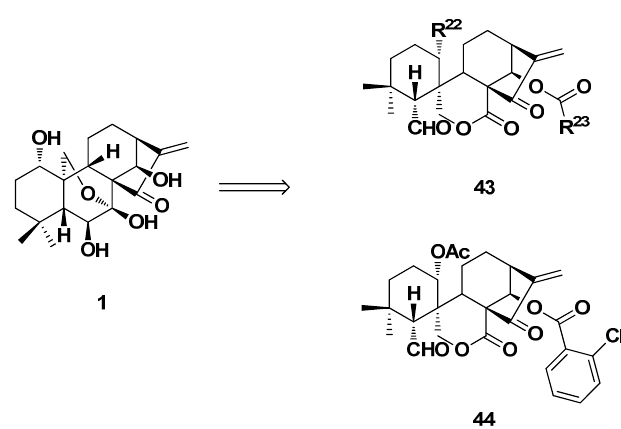
Figure 22. Spirolactone-type 6,7- seco -kaurane diterpenoid derivatives 43 and 44 .